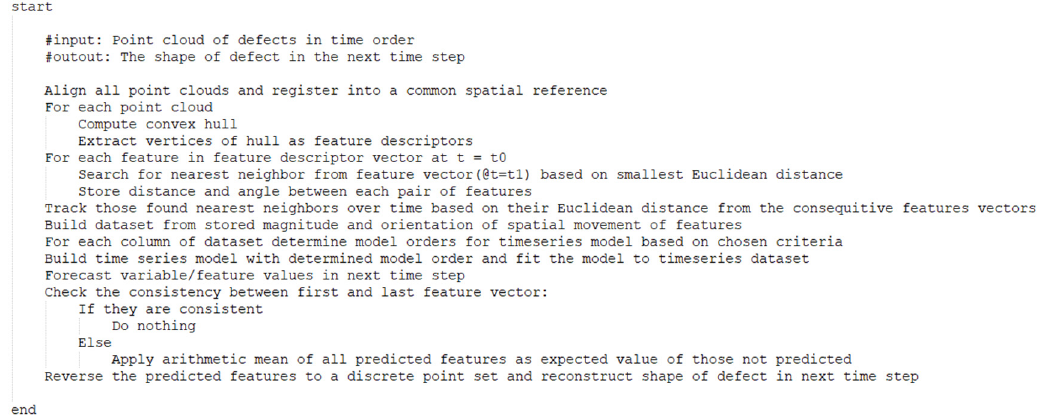
Figure 7. Pseudocode for the proposed methodology.